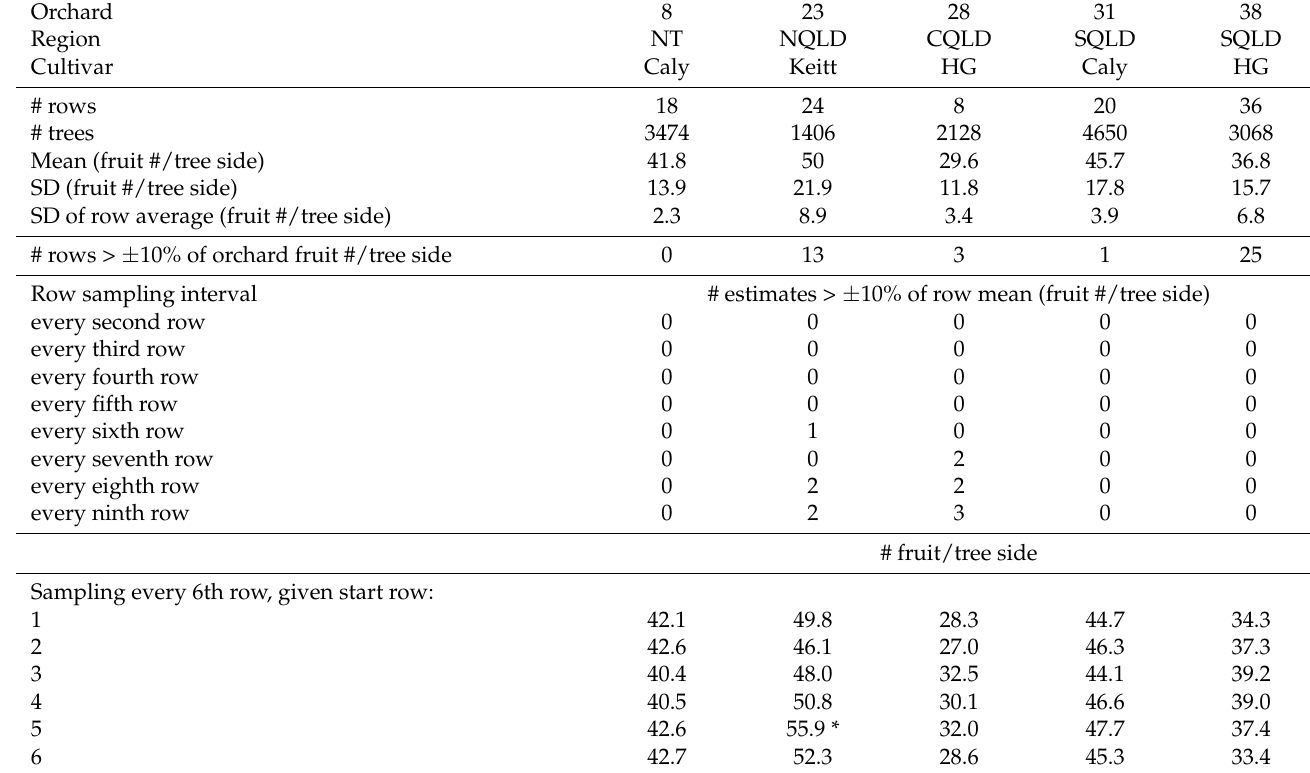
Table 1. Characterization of five orchards varying in location and cultivar in terms of number (#) of rows and tree, mean and SD of machine vision estimated fruit number per tree side, SD of the average fruit count per tree side for individual rows, the number of rows for which the fruit count per tree side was > ± 10% of the average value of the entire orchard, and the number of iterations of a given down sampling interval that were > ± 10% of the orchard average value. Detail is also given for the case of sampling every 6th row, for all start row possibilities. Iterations which exceeded ± 10% of the whole orchard estimate are marked by a